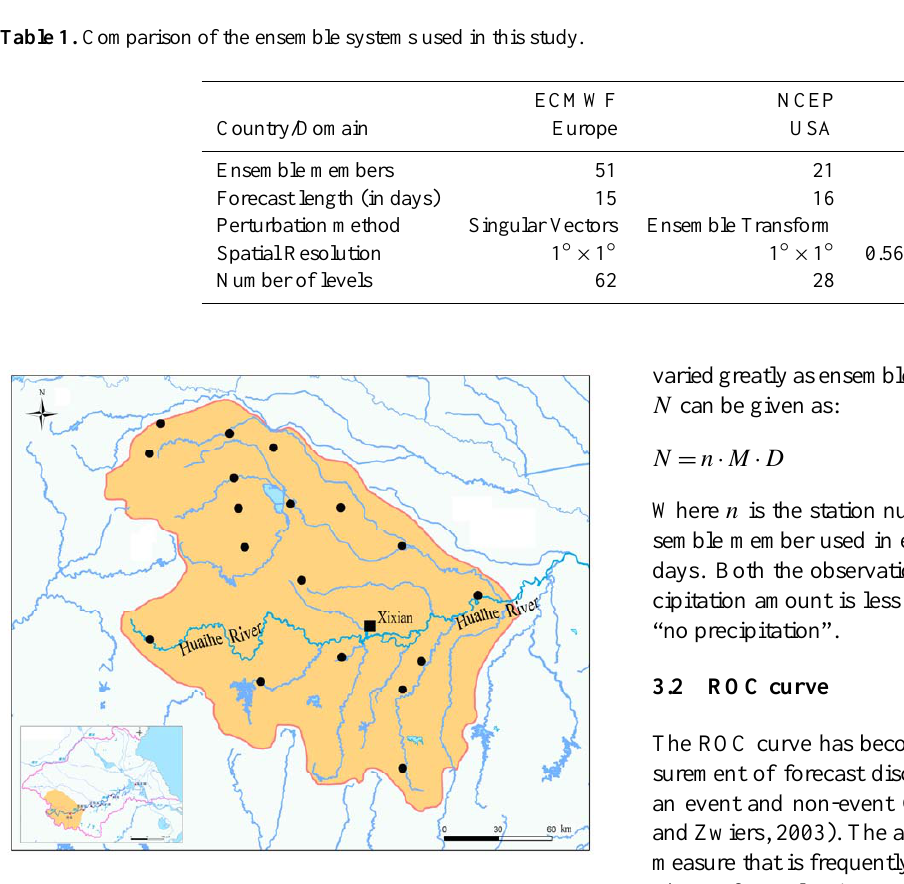
Fig. 1. Illustration of the test catchment and the locations of 19 stations in the test area.